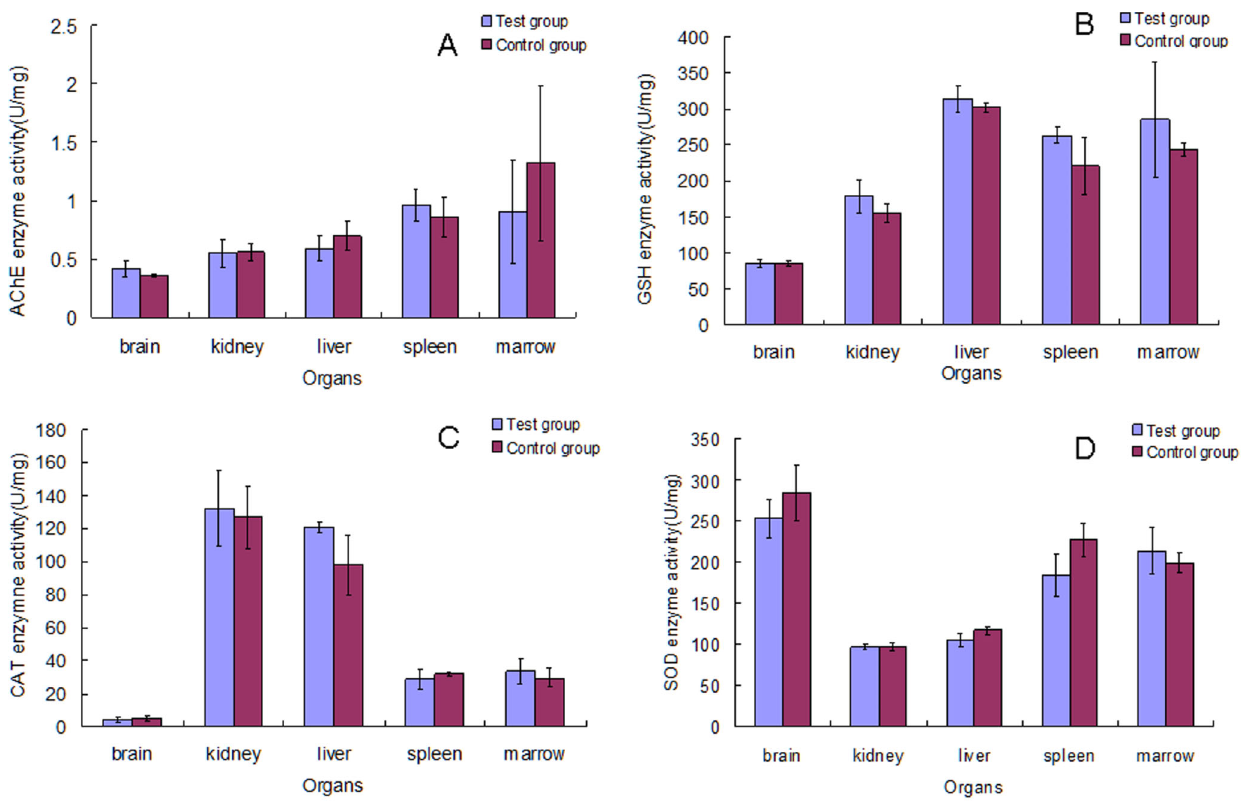
Figure 7. Effect of Cry1Ab protein on the enzyme activity of organs in Swiss rat that feeding for 90 days. The enzyme activity of these organs including brain, kidney, liver, spleen and marrow was assayed. A described the AchE enzyme activity. B described the GSH enzyme activity. C described the CAT enzyme activity. D described the SOD enzyme activity.